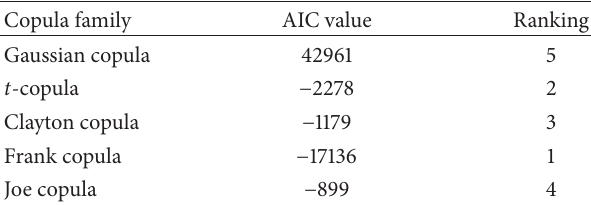
Table 4: Goodness-of-fit for the candidate